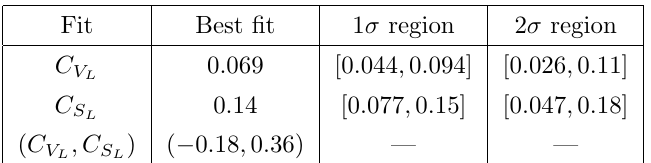
Table 4. The results of our (cid:12)t to R D and R D (cid:3) including the new Belle combined measurement [36]. The (cid:12)rst row shows the best (cid:12)t point and (cid:27) -regions (cid:12)tting to C V vanishing. The second row shows the same for C S coe(cid:14)cients set to zero. The third row shows the best (cid:12)t point for a 2D (cid:12)t to Re C V (cid:0) 4Re C T ((cid:3)), again for (cid:3) = 2 TeV.